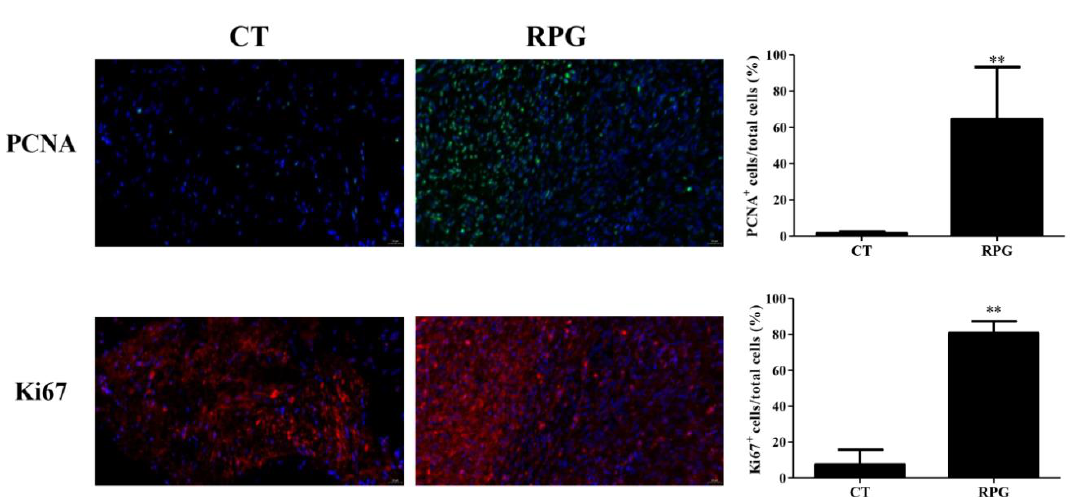
Figure 2. Double-labeling immunofluorescence staining for proliferating cell nuclear antigen (PCNA) ( green ) and Ki67 ( red ) in post-natal dairy cows endometrium. Scale bars = 20 μm. Data are presented as the means ± SD. Compared to control diet: ** p < 0.01.